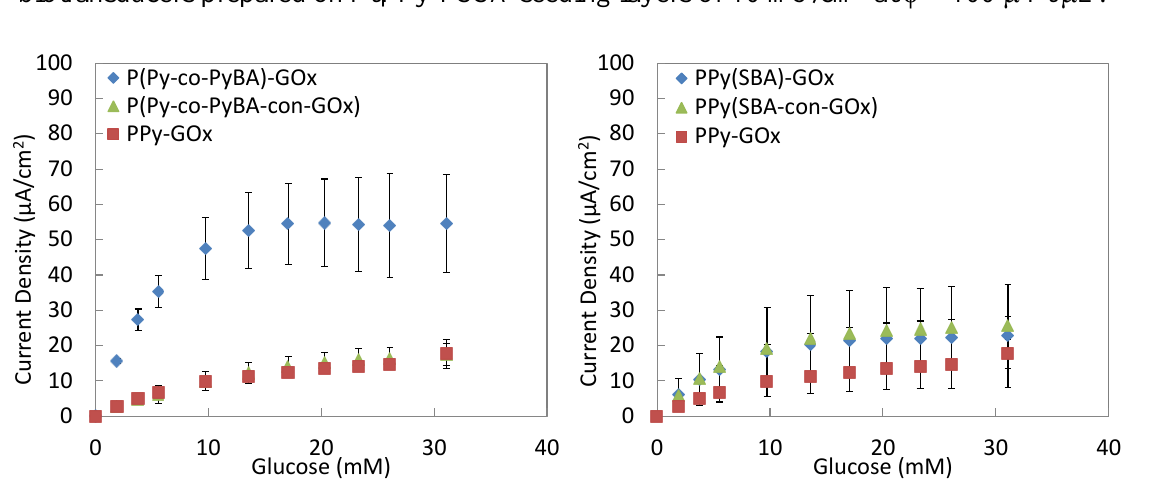
Figure 5. Dose response curves of ( left ) monomerized and ( right ) sulfonated